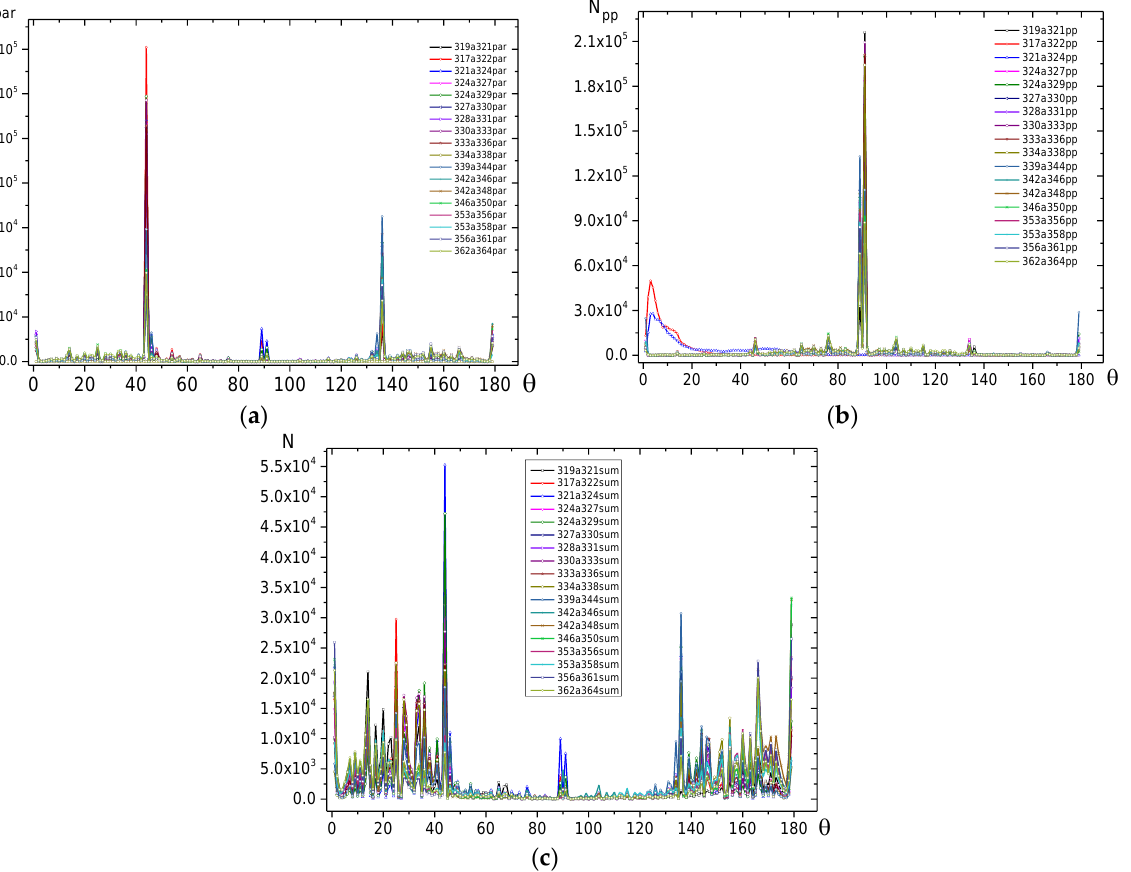
Figure 15. Angular distributions of the local pure shears ( a ), rupture angles ( b ) and their vector sum ( c ) . Each first (second) number of the legend on ( a – c ) reflects the number of the first (second) frame. It can be seen that for pure shear (functional F (cid:107) ( θ S ) ) at all stages of deformation and destruction of the “copper − steel” system, the main role is played by the maximum shear stresses, which are characterized by angles ± 45 ◦ . In the coordinate system adopted in the work, where the OY axis is directed downward, they correspond to the angles 135 ◦ and 45 ◦ . It is at these angles that the greatest number of local shears is observed. In second place are the normal stresses associated with the angles 0 ◦ and 180 ◦ . Although the external force is applied in this direction, the number of separation elements is approximately an order of magnitude smaller (Figure 14a,b). Two deviations from this rule can be explained by the running-in effect, when the material near one of the fillets is actively deformed. For the rupture functional F ⊥ ( θ S ) the key is the angle 90 ◦ (Figure 15b). If functional (2) is used to identify the shear, then in addition to the above angles, a whole spectrum of additional angles will appear, lying in the range 4 < θ < 45 ◦ . This is obviously due to the interference effect, where the modulus sign is the sum of the two .